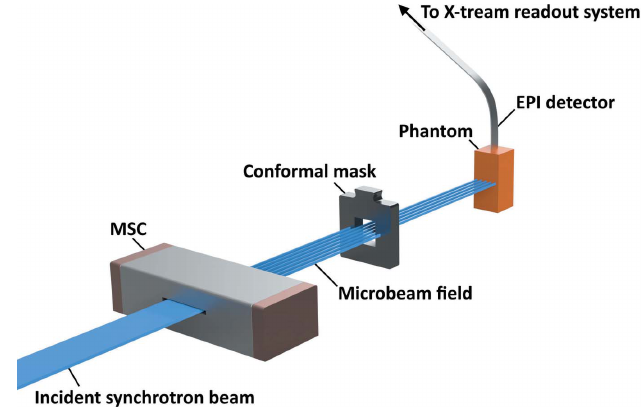
Figure 1 Experimental setup for X-Tream dosimetry as part of the procedure used to calibrate simulations to experimental dose rates measured with the X- Tream